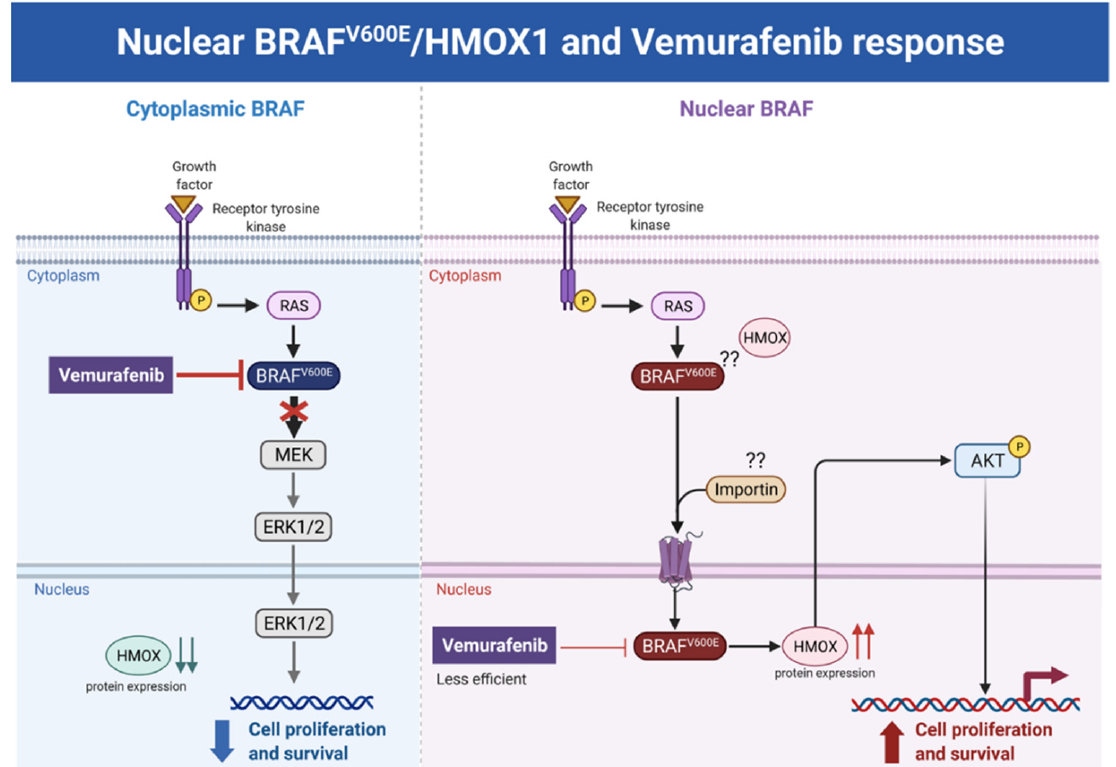
Figure 7. Hypothetical model of the melanoma resistance to vemurafenib. Melanoma cells with cytoplasmic BRAFV600E and low HMOX-1 expression are more sensitive to vemurafenib treatment than cells with nuclear BRAFV600E, high HMOX-1 expression, and an activated AKT pathway.